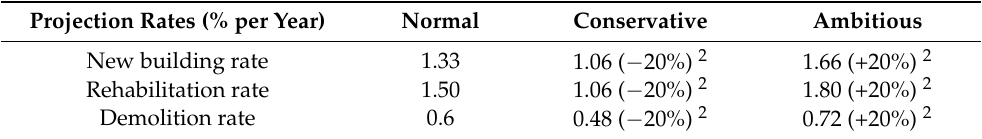
Table 3. Projection rates for building stock development.